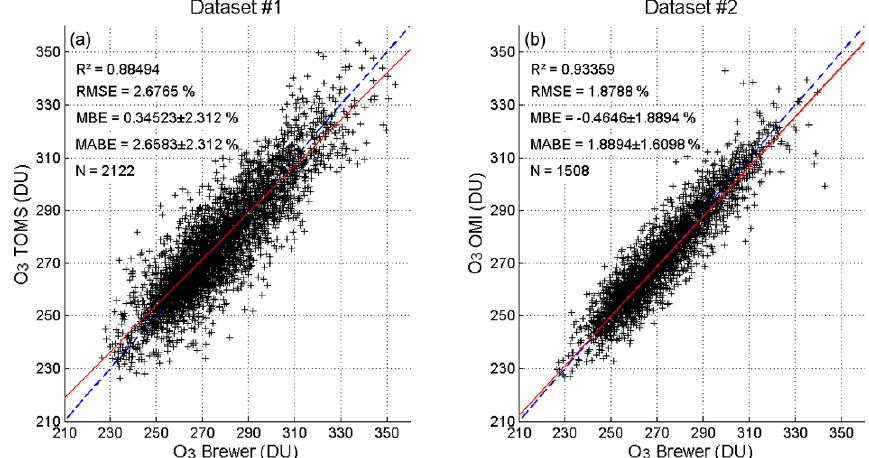
Figure 2. Scatterplot for the TOC in the region of the Southern Space Observatory obtained from the Brewer spectrophotometer and (a) TOMS (Dataset #1) and (b) OMI (Dataset #2) satellites. The dashed line (blue) represents the unit slope to which the data comply, and the solid line (red) is the regression